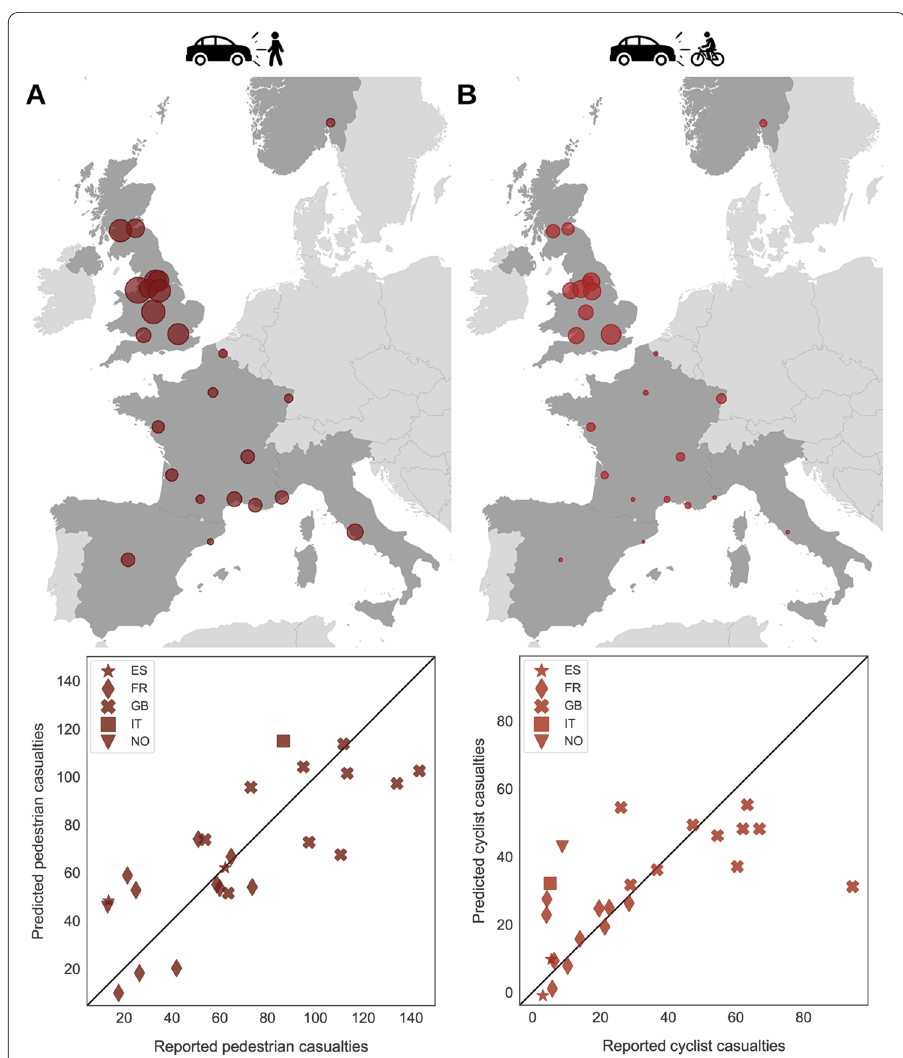
Figure 5 Collisions involving vulnerable road users: maps of the collisions and performance of the models. Maps are showing the reported numbers of vulnerable road users killed or seriously injured by a car or taxi, normalized by population. Scatter plots show the corresponding fit of the model with 2 independent covariates (see Tab. S1). Panel A refers to pedestrians, while panel B refers to cyclists. Colours correspond to those used in the legend of Fig. 3. Of the 24 cities under study, the 10 cities with the lowest vulnerable road users’ safety are British cities. Regression results showed adjusted R 2 = 0.55 in panel A and adjusted R 2 = 0.36 in panel